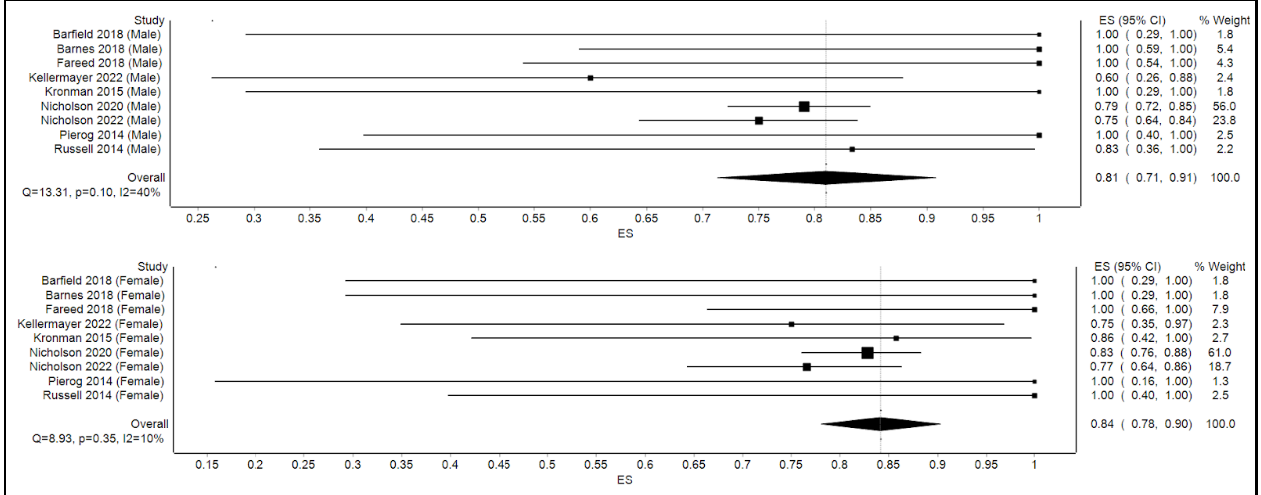
Figure 3. Forest plot displaying clinical efficacy of FMT by gender.